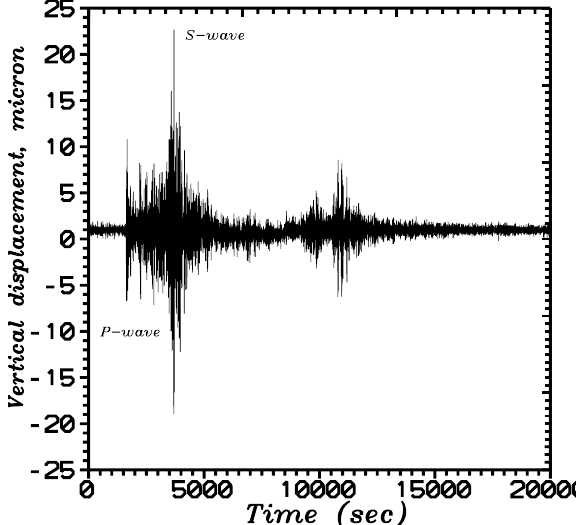
FIG. 13. (Color) Spectra of ground motion in the Aurora mine, the TARP tunnel, and the Tevatron magnet